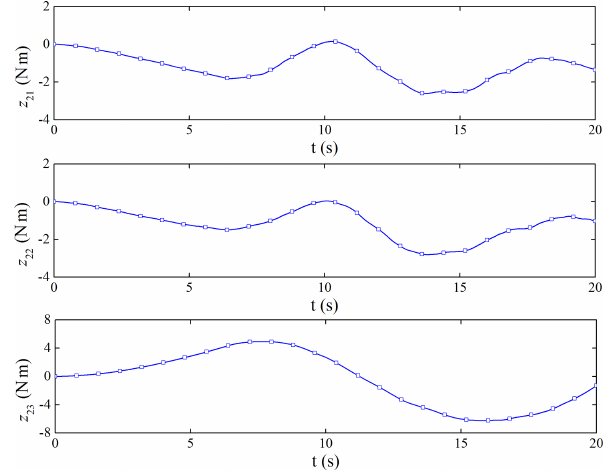
Figure 7. Attitude-tracking curve.